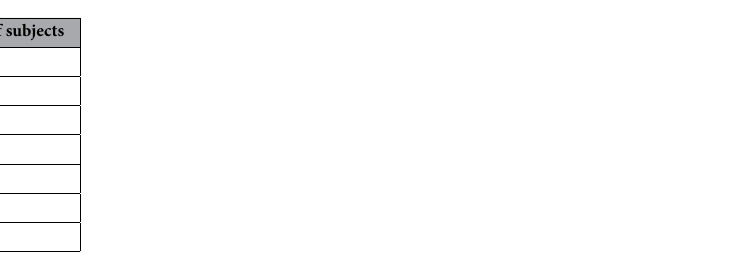
Table 1. Unique PTRA CCA T values (only subjects with non missing data are